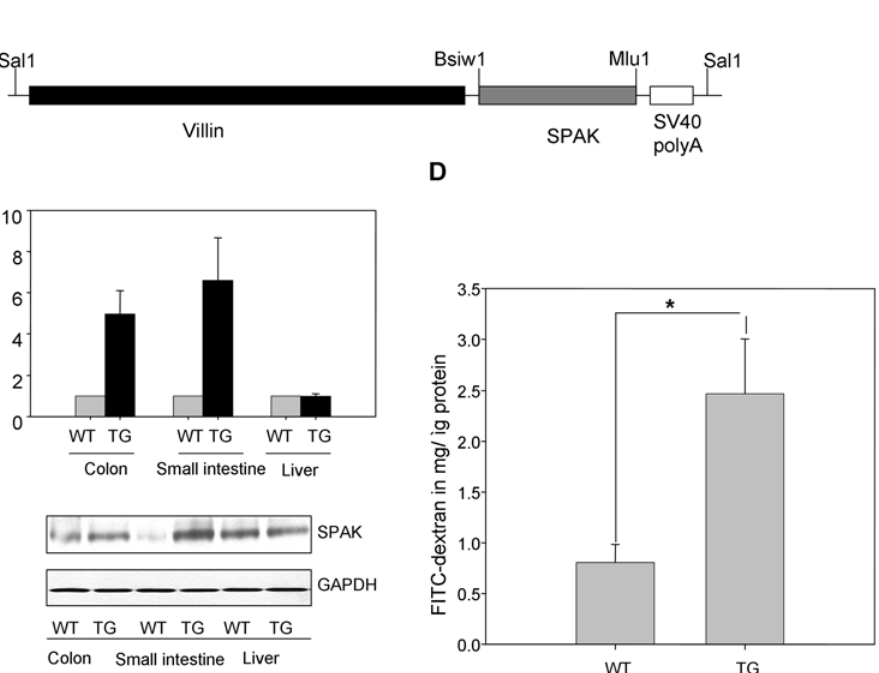
Figure 9. SPAK is involved in epithelial barrier function invivo. A. Schematic diagram of villin/SPAK transgene construct, full length SPAK cDNA was cloned into villin vector by Bsiw1/Mlu1 sites; villin/SPAK was digested with Sal1 before microinjection. B. SPAK is tissue-specifically over- expressed in intestine by real time PCR with samples from small intestine, colon and liver. C. SPAK is specifically over-expressed in intestine by western blot with samples from small intestine, colon and liver. D. in vivo permeability assay in villin/SPAK transgenic mice, WT: wide type; TG: transgenic mice, ** p , 0.01.